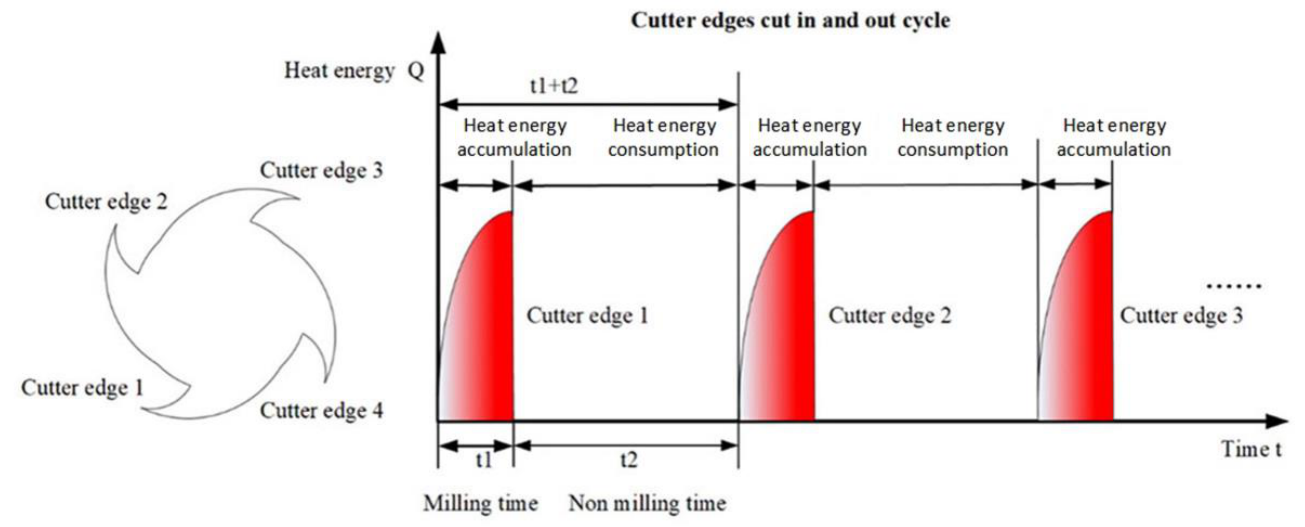
Figure 8. Left: Tool showing the four teeth. Right: Energy changes in the edges during